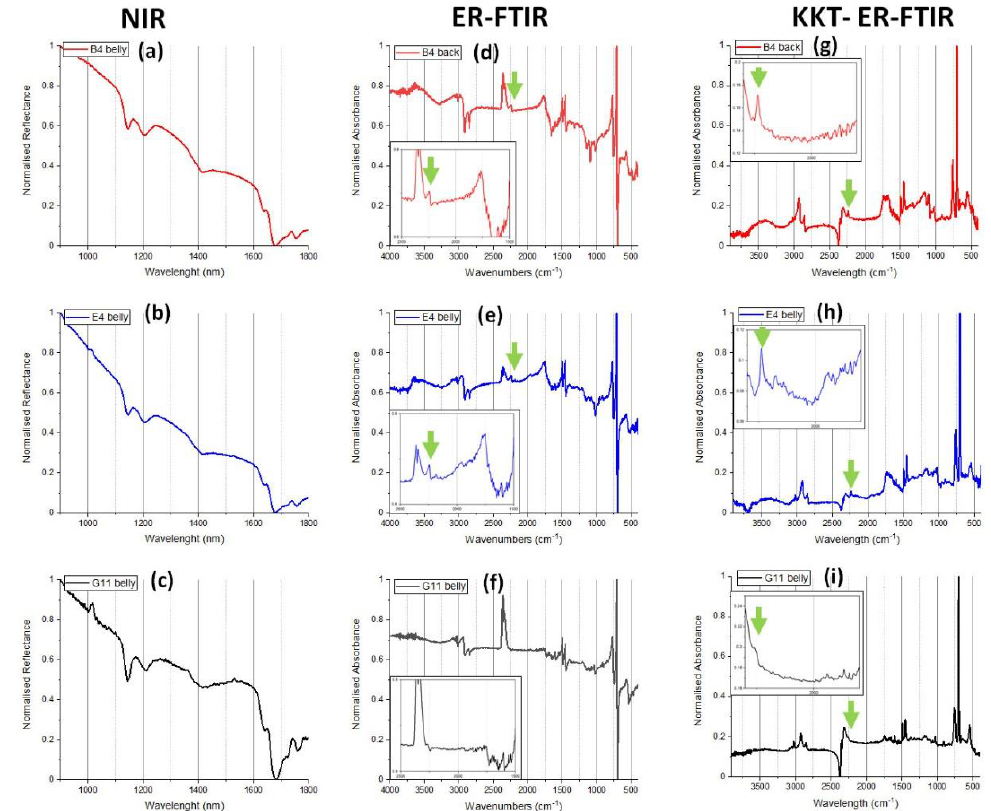
Figure 11. ABS was tentatively identified in dolls E4, B4 and G11 using NIR ( a – c ). NIR spectra were compared to ER-FTIR spectra ( d – f ) and KK transformed ER-FTIR spectra ( g – i ) to distinguish between PS and possible ABS. Where a nitrile band was visible in ER-FTIR spectra at ~2250 cm −1 (as indicated with green arrows) ABS was identified. For doll G11, there was only a weak indication of a nitrile band observed in ER-FTIR spectra (i).